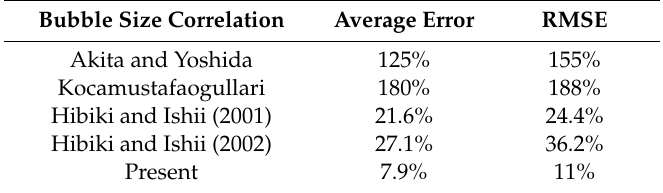
Figure 9. Comparison of the predicted local bubble size and experimental data with ( a ) Akita and Yoshida, ( b ) Kocamustafaogullari, ( c ) Hibiki and Ishii (2001), ( d ) Hibiki and Ishii (2002), and ( e ) the present correlation. Table 6. Average error and RMSE of the bubble size correlation for each